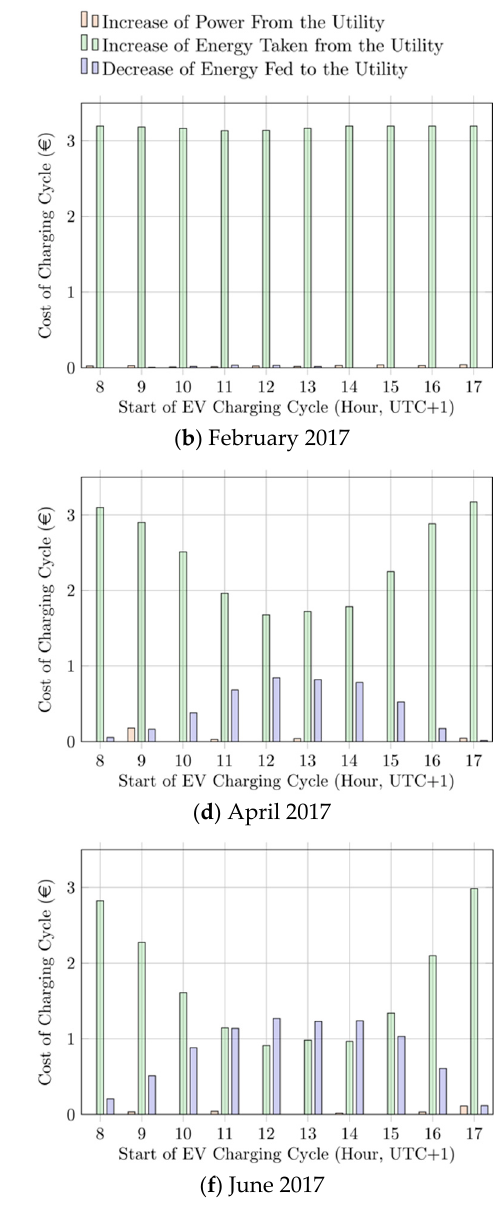
Figure 10. Electric vehicle (EV) charging cost components (€) from January to June 2017, as depicted from sub-figure ( a ) to sub-figure ( f ), respectively. The cost components are presented for each charging cycle, depending on the time of arrival of the EV at the charging station. UTC: Universal Time Coordinated.